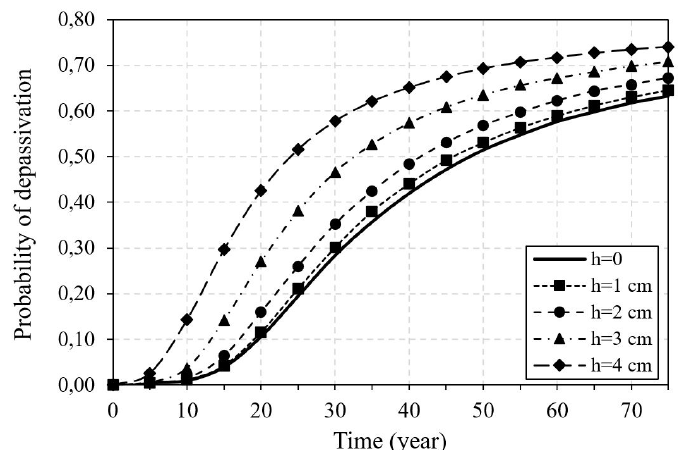
Figure 8. Influence of crack length on the probability of reinforcement